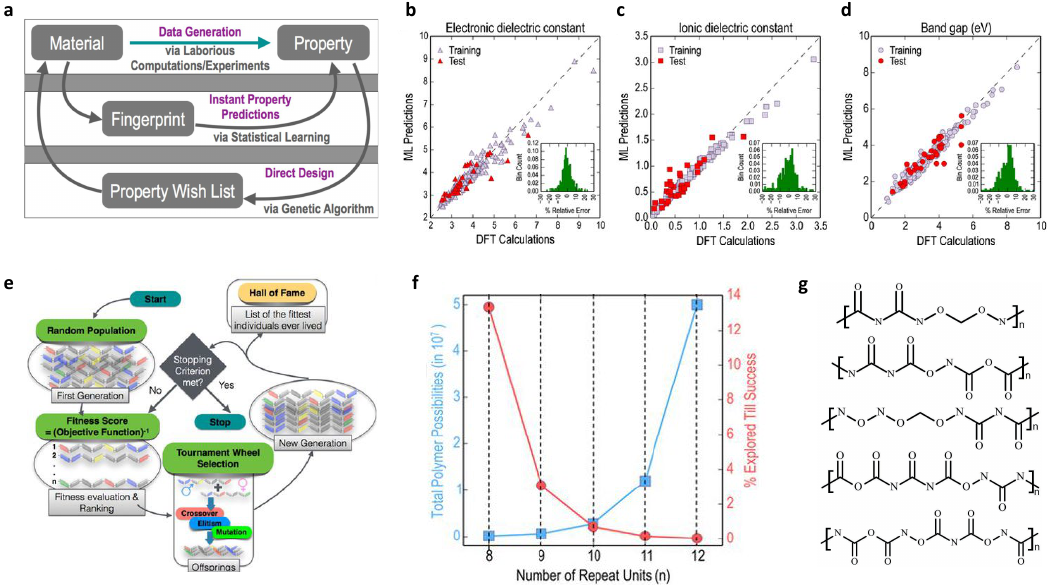
Figure 2. ML-guided design of dielectric polymers. ( a ) Three phases involved in this design approach; ( b – d ) the performance of ML model on the desired properties: electronic dielectric constant, ionic dielectric constant, and band gap; ( e ) the flow chart of genetic algorithm to identify promising candidates with desired properties; ( f ) the relation between number of building blocks and the number of possible polymers, as well as the percentage of the polymers needed to be considered; ( g ) the optimized molecular structures with 8 ∼ 12 units (C and H are not displayed explicitly). The figures are adapted from Reference [9] with permission, copyright 2016 Springer